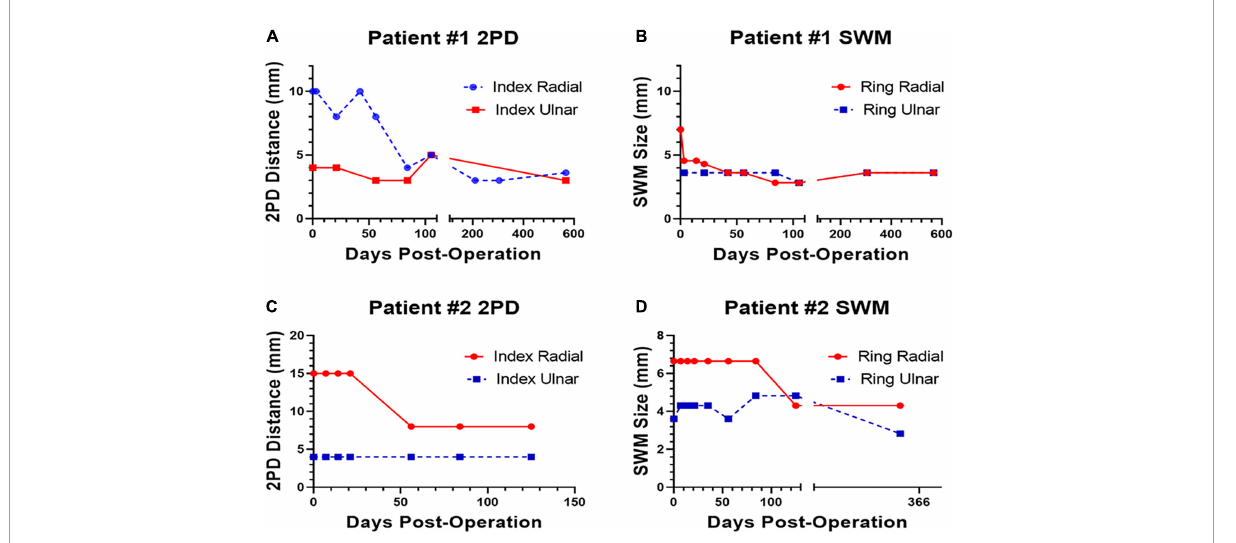
FIGURE1 Polyethylene glycol (PEG)-fusion 2PD and Semmes–Weinstein monofilament (SWM) scores on the injured site (red, solid line) and on the uninjured site (blue, dotted line) plotted versus postoperatively (PO) days for Patient #1 (A,B) and Patient #2 (C,D)